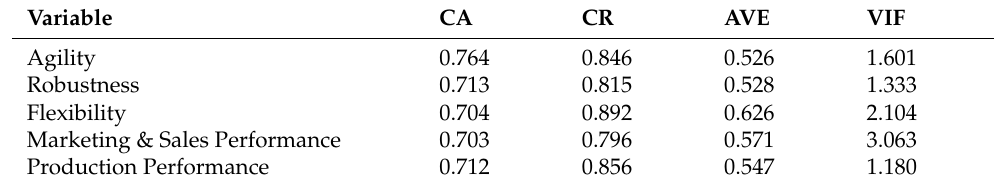
Table 4. Convergent Validity.